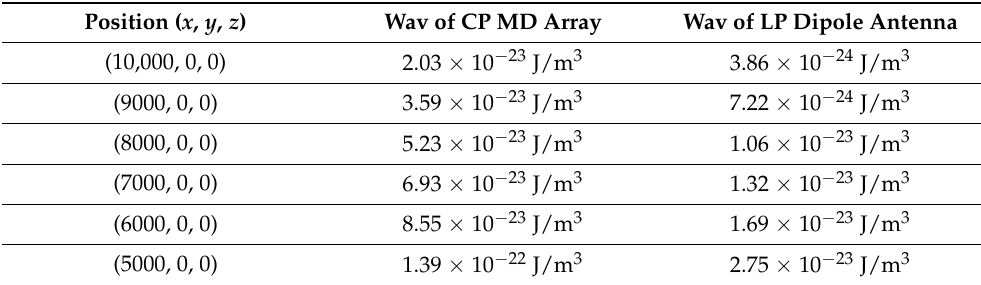
Table 2. Comparison of the Wav normalized according to the